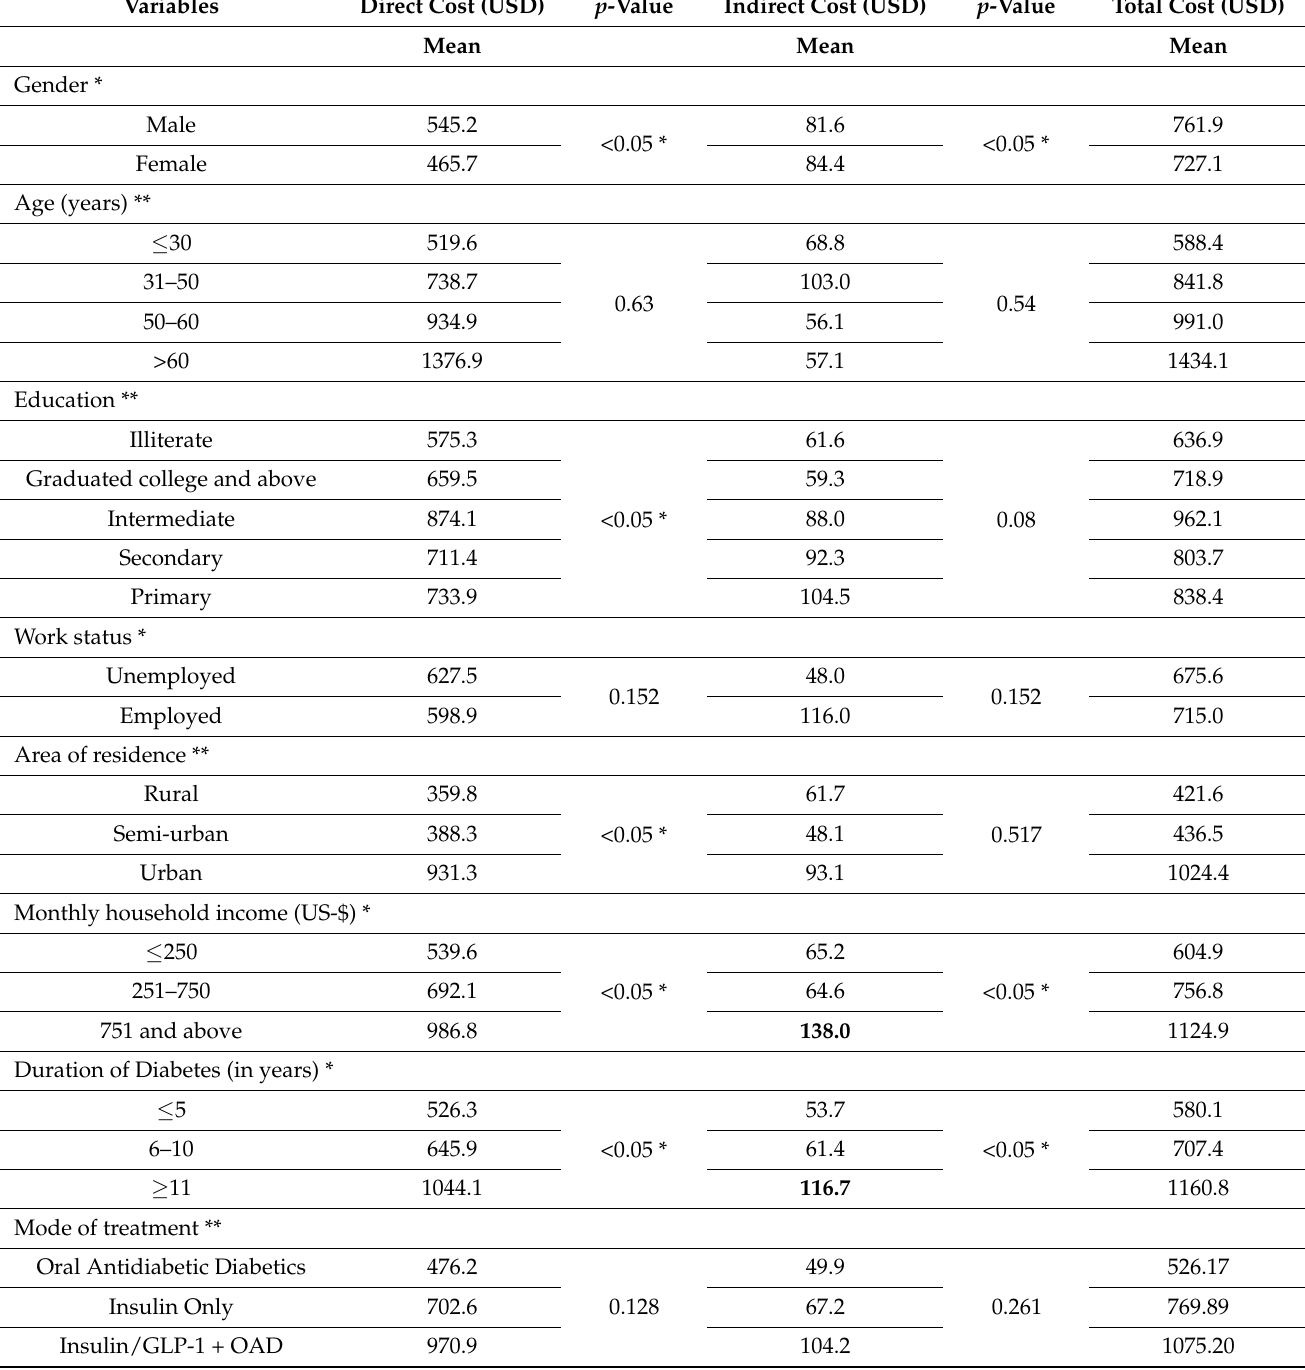
Table 4. The cost of diabetes management and socio-demographic and clinical